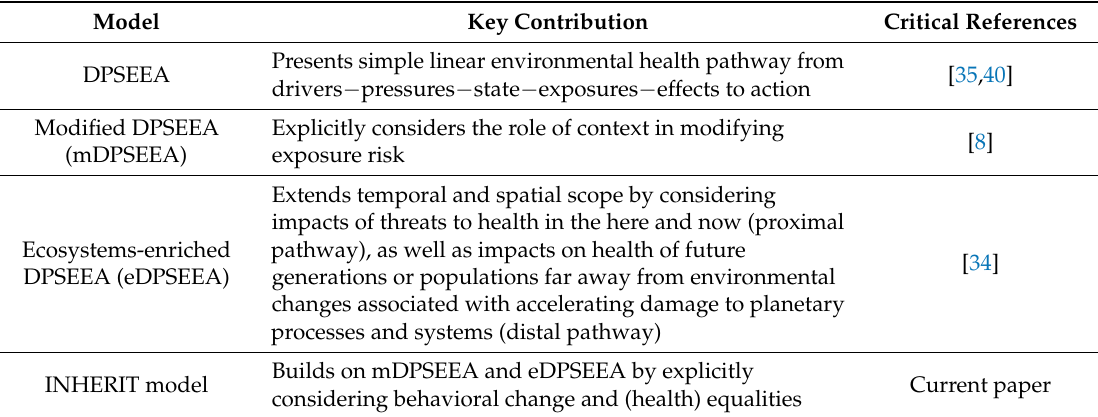
Table 1. Differences between DPSEEA models and INHERIT